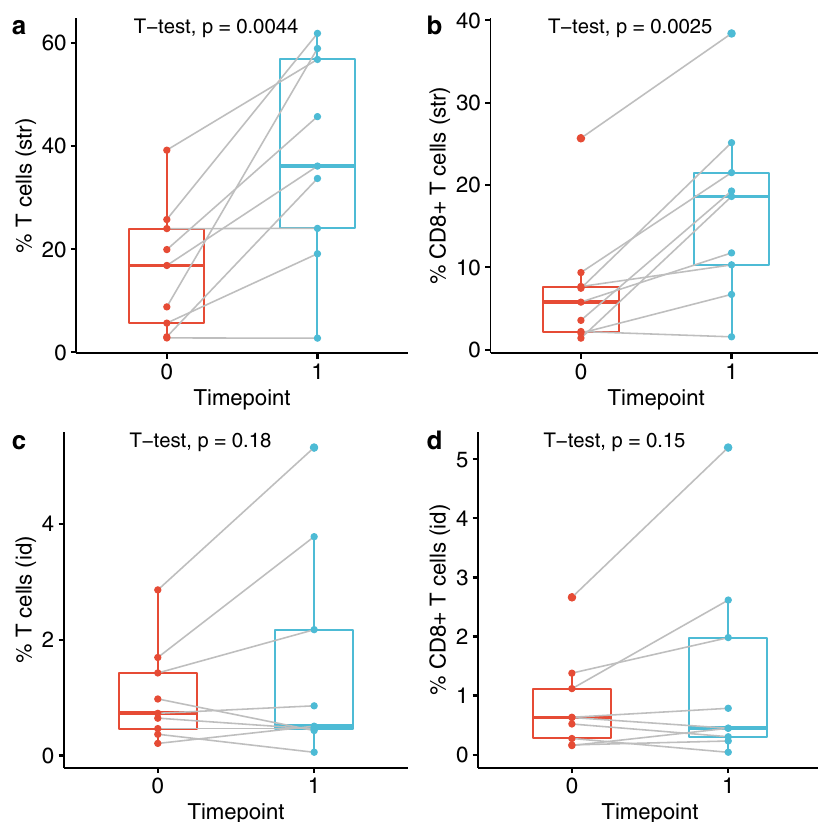
Fig. 4 Stromal T cell densities increased in response to intralesional anti-PD-1 therapy. Total T cell ( a , c ) and CD8 + T cell ( b , d ) densities in the stromal regions ( a , b ) and intraductal regions ( c , d ) pre-therapy (timepoint 0) and post-therapy (timepoint 1). The bounds of each box represent the interquartile range (IQR). The horizontal line within a box is the median. Whiskers extend to the largest and smallest values no further than 1.5*IQR. Outlying points beyond the ends of the whiskers are plotted individually. Each pair of connected points represents one patient ’ s data; p -values are derived from paired t